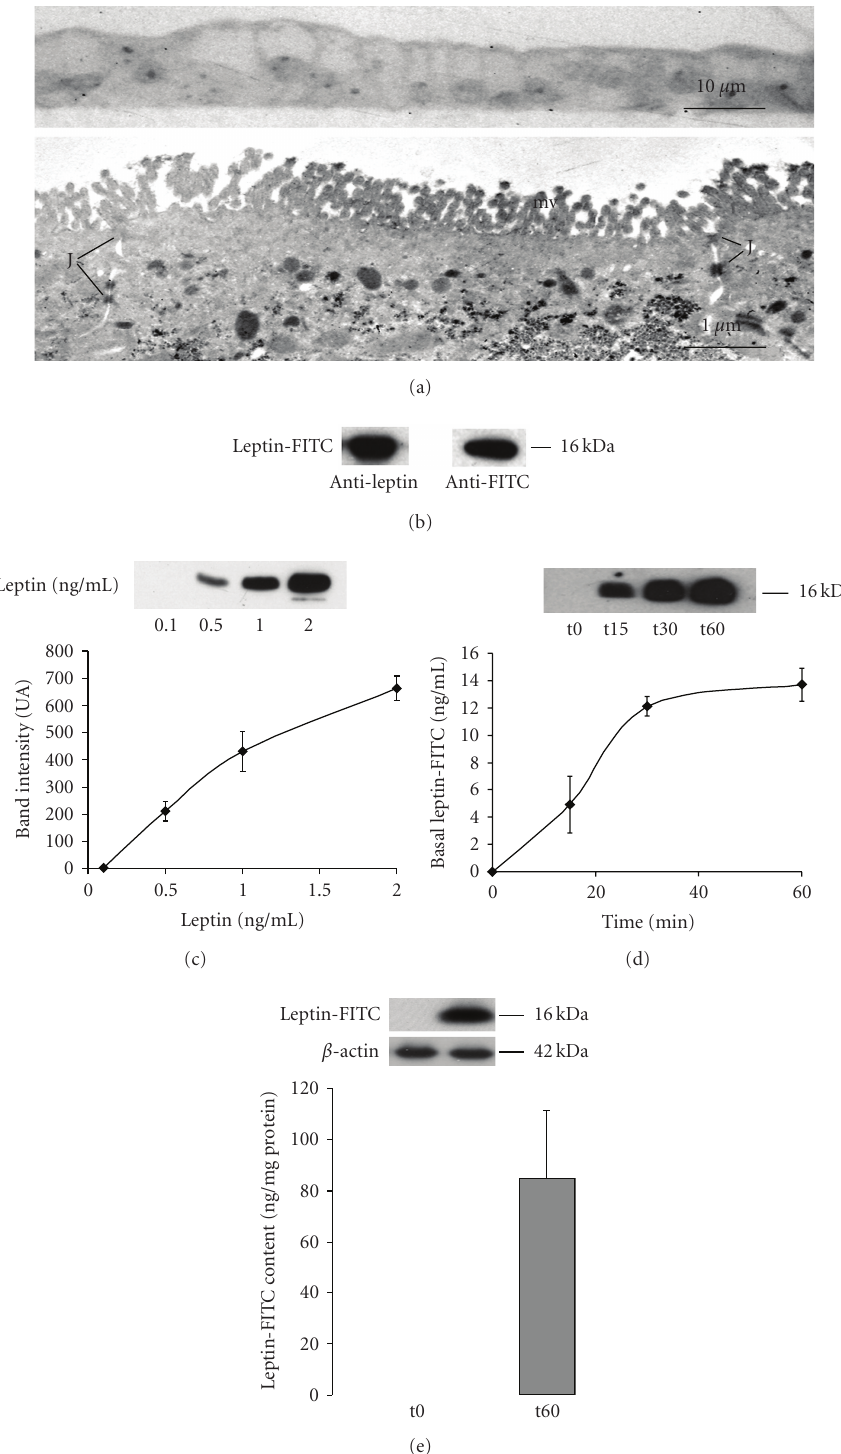
Figure 1: Transcytosis of leptin through Caco-2/15 cell monolayer . (a) Intestinal caco 2/15 cells grow as a tight polarized monolayer displaying apical microvillosities (mv) and tight junctional complexes (J). (b) Upon preparation of the leptin-FITC complex, leptin is revealed by Western blot as a single band of 16kDa using antibodies against leptin as well as against FITC. (c) Quantification of leptin by Western blot is linear up to 1 ng/mL. (d) Leptin-FITC (10 μ g/mL) added to the apical compartment of Caco-2/15 cell monolayer is transported to the basal compartment along with time and appears to be saturable. (e) Leptin intracellular content was raised significantly at the end of the experiment (60 minutes). Results are expressed as mean values ± s.e.m ( n = 4 for each